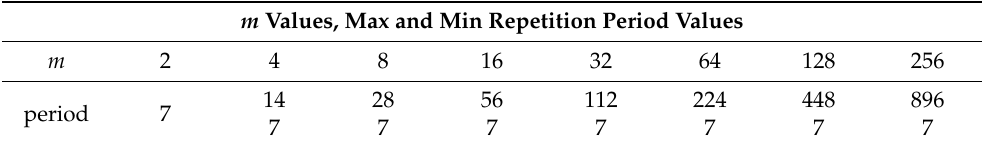
Table 3. Dependence of repetition periods of the output sequence of classical AGF for some values of m on the whole set of values X (0).